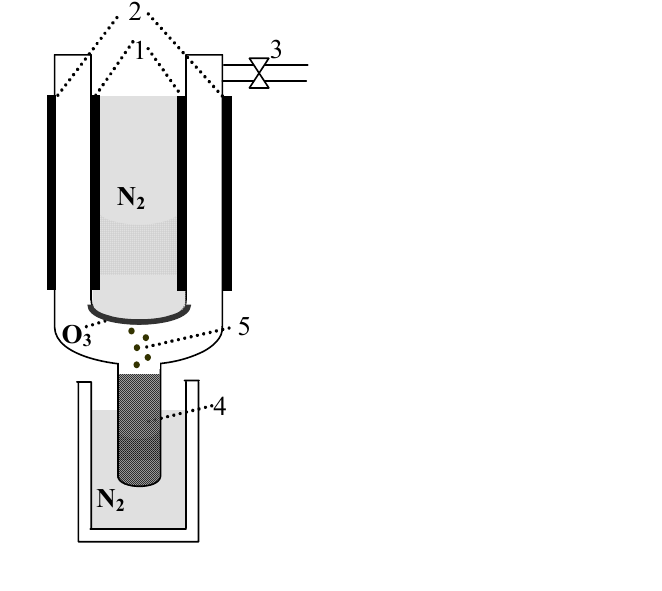
Fig. 4 Side view of double wall glass reactor for preparation of ozone: 1, 2 - inner and outer cylindrically shaped electrods, 3 - the inlet valve, 4 - silica gel, 5 - drops of O 3